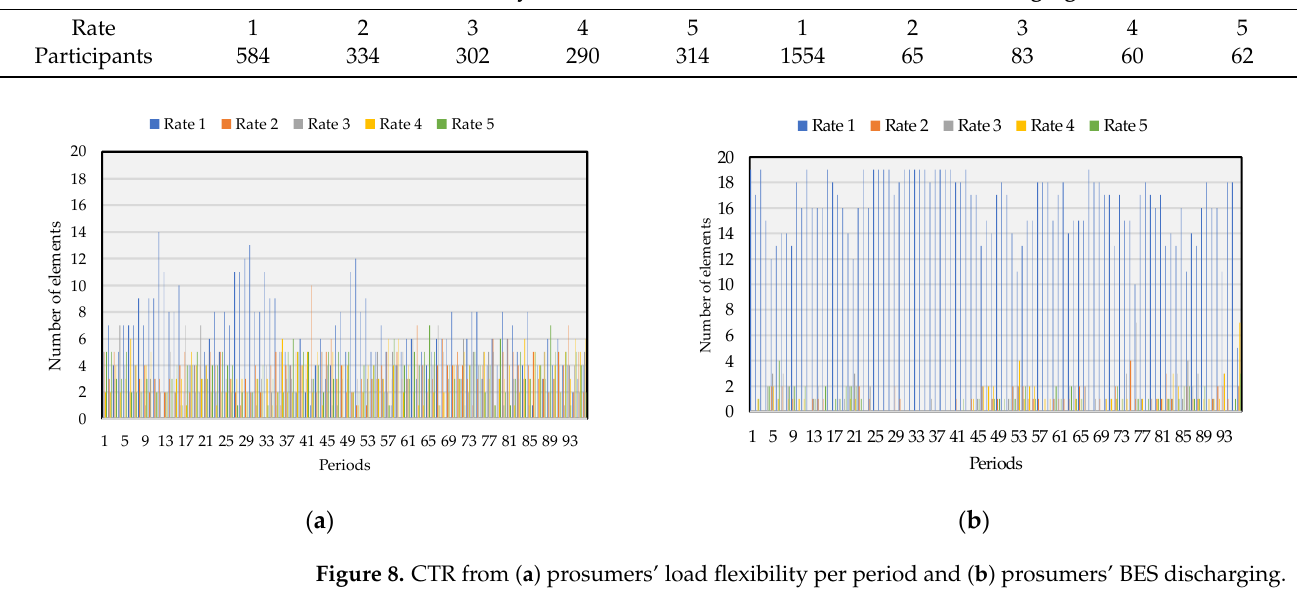
Table 7. The number of participants per rate throughout the day. Actual Flexibility (m.u.)